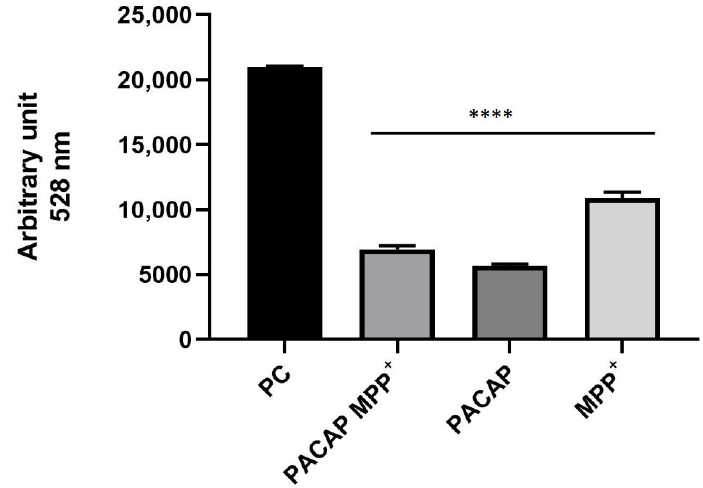
Figure 13. DCFH2-DA assay on 3D SH-SY5Y/RA treated with both gH625-lipoPACAP-Rho and MPP + (PACAP MPP + ), 3D SH-SY5Y/RA treated with gH625-lipoPACAP-Rho (PACAP) and 3D SH-